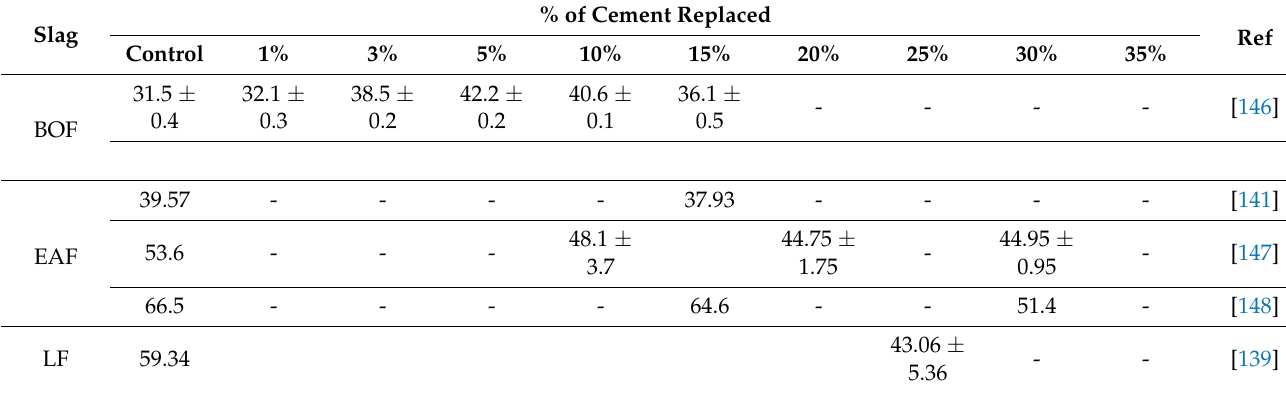
Table 12. Influence of slags on the compressive strength